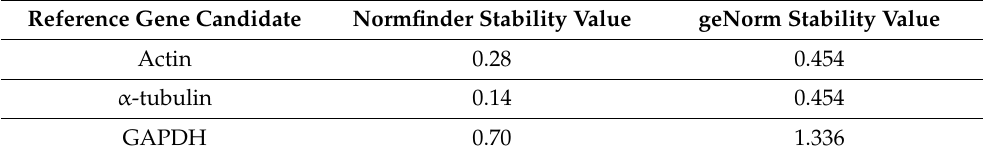
Table 2. Reference gene validation results by Normfinder and geNorm